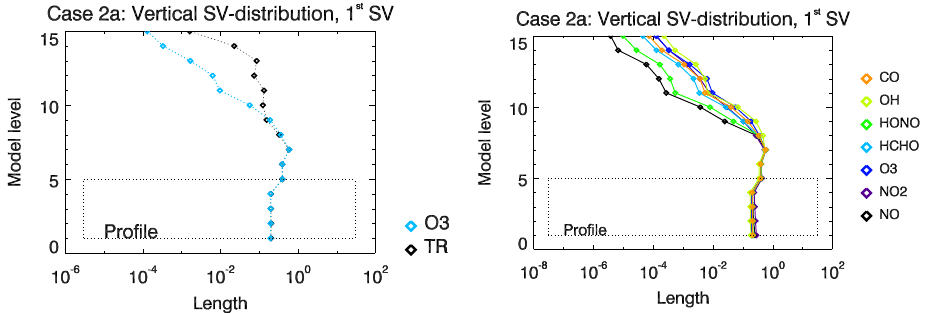
Figure 2. Vertical placement of the first singular vector with respect to initial value uncertainties for case 2a. Illustrated is the length of the vertical singular vector per model level for passive tracer and ozone (left panel) as well as for CO, OH, HONO, O 3 , NO 2 , and NO (right panel). Colour coding of each compound is denoted to the right of each panel. The black box indicates the height of the final profile VP( t F ).